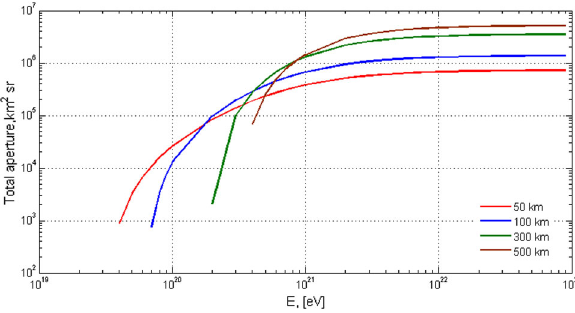
Fig. 3 Total aperture of UHE cosmic rays for a lunar orbital ULW radio antenna at different altitudes of 50, 100, 300, and 500km with a sensitivity of 1.34 uV/m/MHz